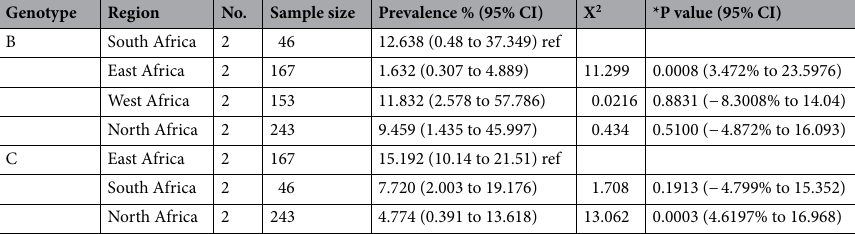
Table 3. Meta-analysis of the relative prevalence of the emerging genotypes B and C on the African continent by region. *P value < 0.05 statistically significant.